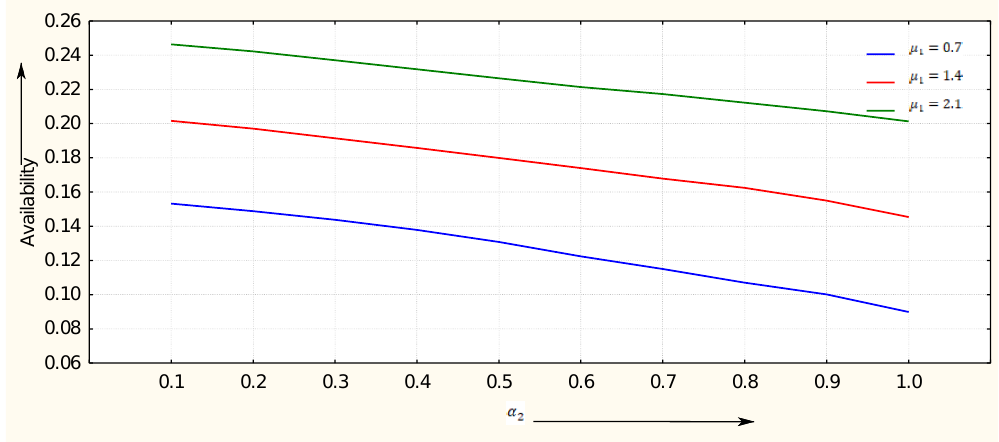
Figure 8. Behaviour of availability w.r.t. 𝛼